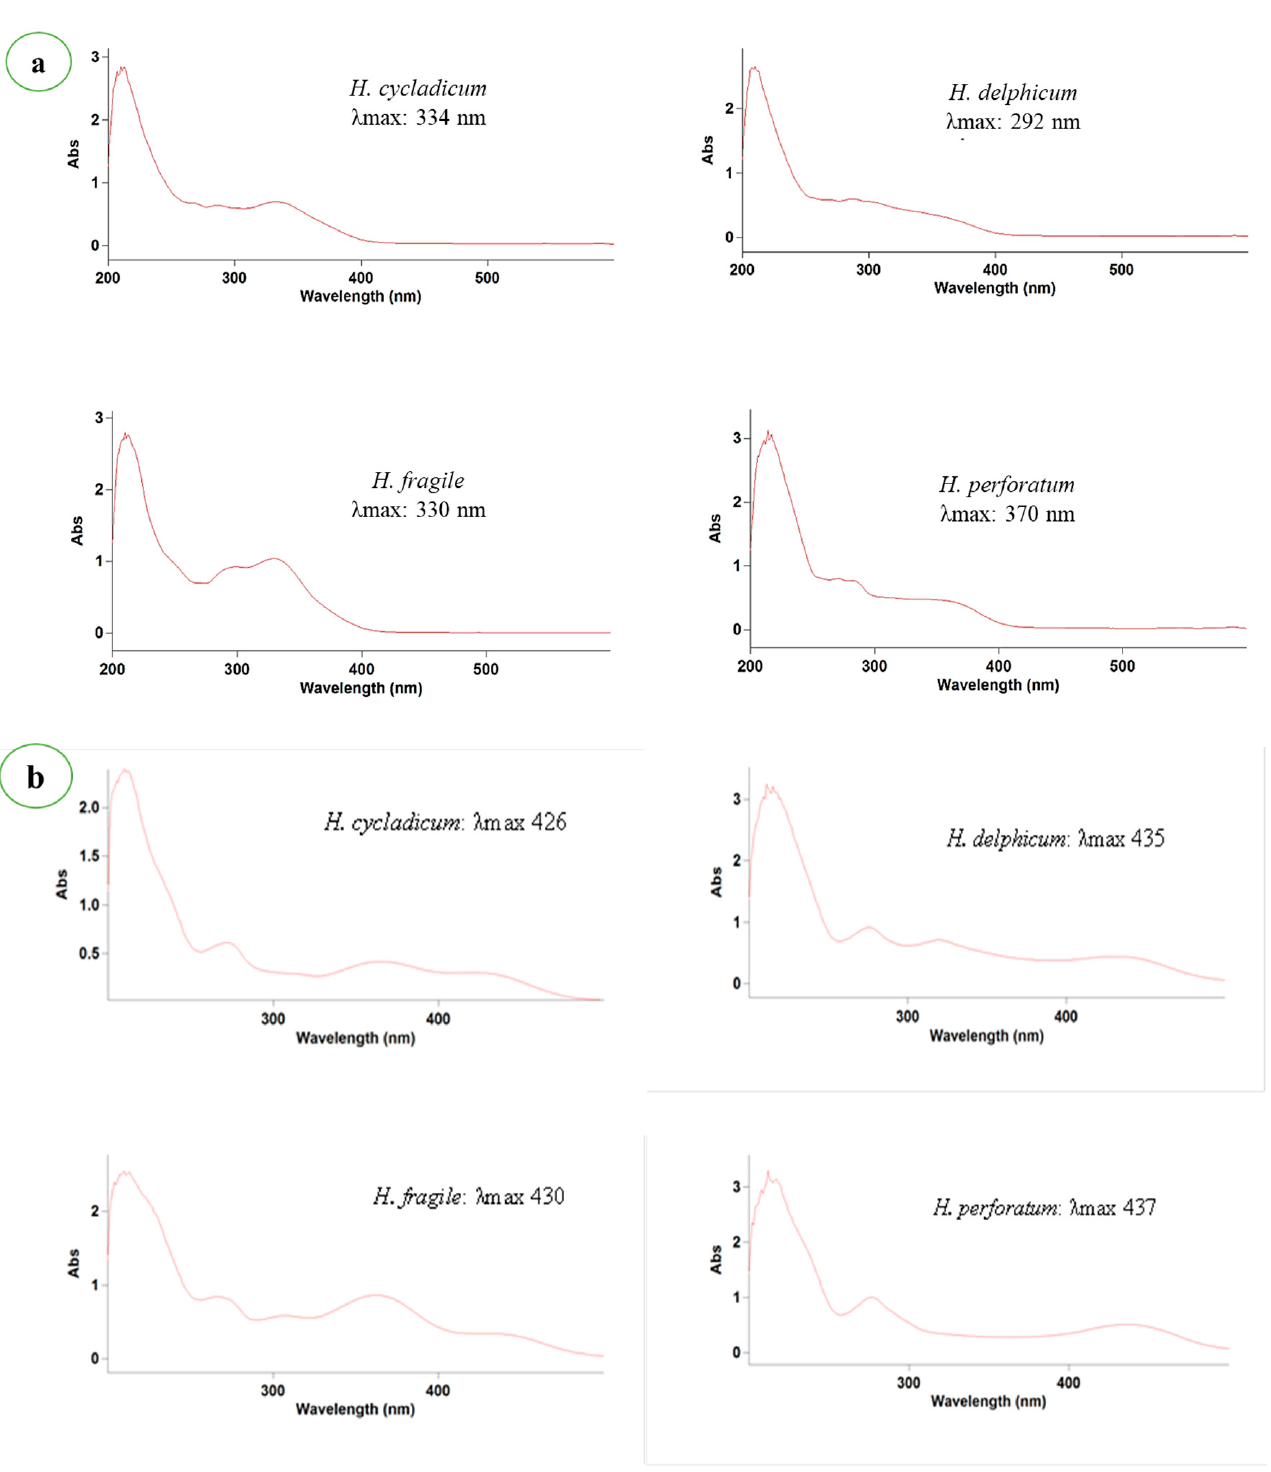
Figure 2. ( a ) UV-Vis spectra of H. cycladicum , H. delphicum , H. fragile , and H. perforatum extracts. ( b ) UV-Vis spectra of H. cycladicum , H. delphicum , H. fragile , and H. perforatum extracts after complexing with AlCl 3 reagent.